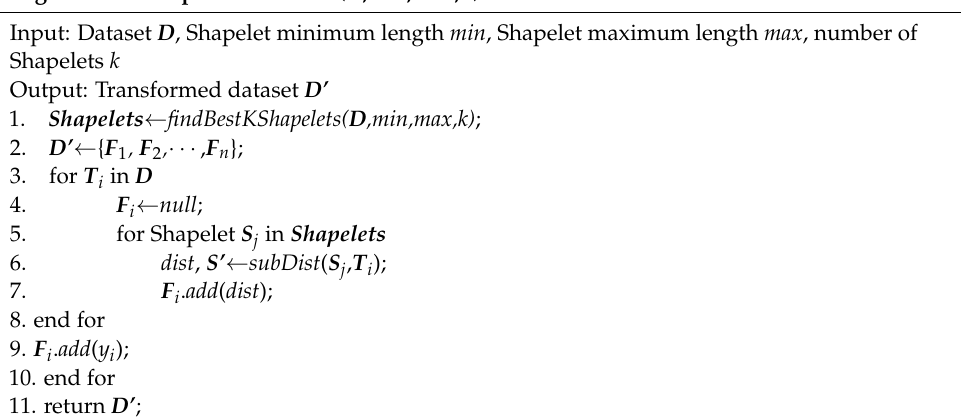
Algorithm 1. shapeletTransform( D , min , max , k